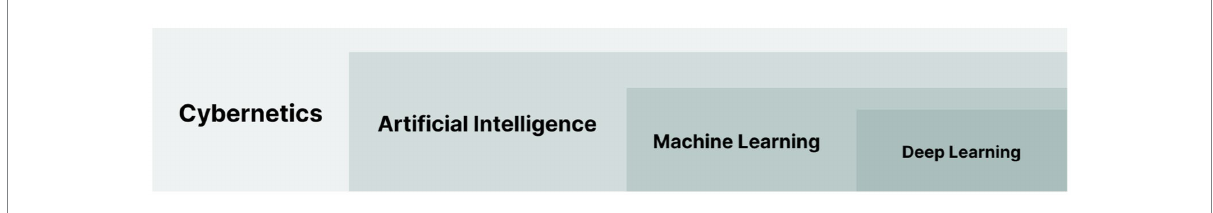
FIGURE 1 Representation of cybernetics as the conceptual predecessor of AI used with permission from Lomas J. D. et al.